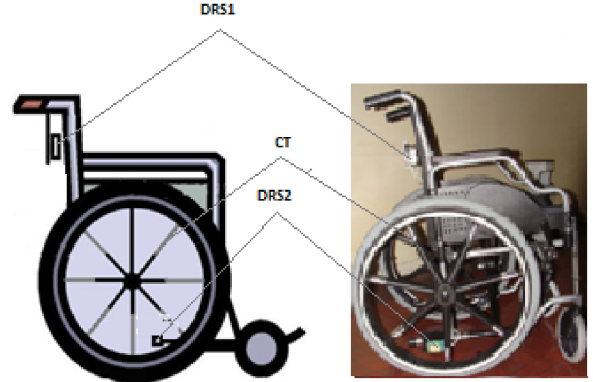
Figure 3. The architecture of a smart wheelchair with Doppler radar for vital signs and motor activity monitoring: (DRS1, DRS2 = Doppler radar sensors; CT = conductive